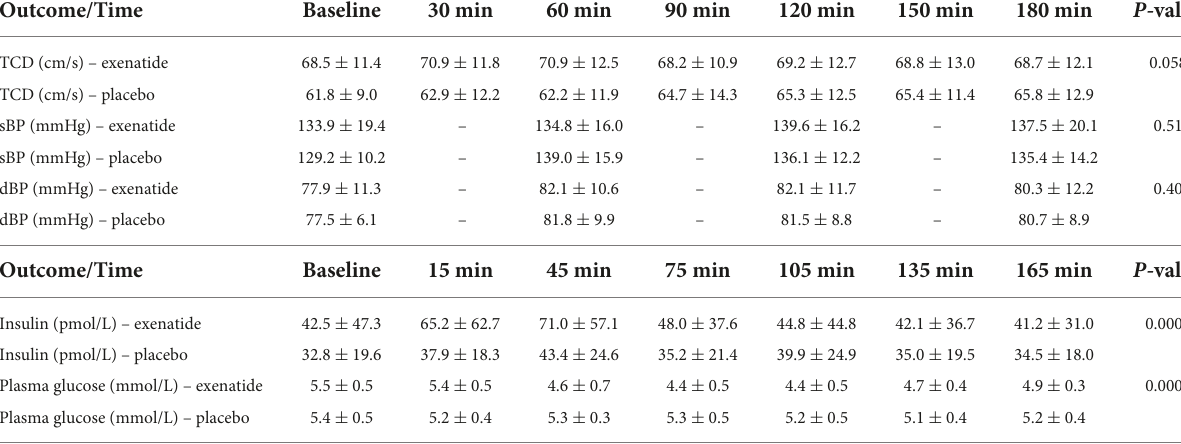
TABLE 2 Data of repeated measurements.